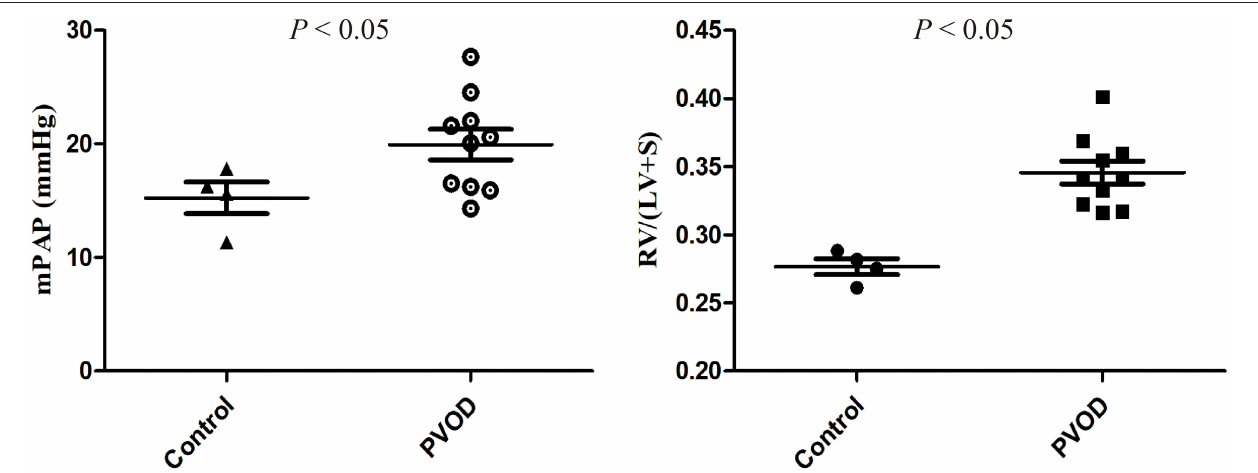
FIGURE 3 | The mPAP and RVHI in control and MMC-induced PVOD rat. The control group ( n = 4 rats) and the PVOD group ( n = 10 rats). LV, left ventricular; mPAP, mean pulmonary arterial pressure; MMC, mitomycin-C; PVOD, pulmonary veno-occlusive disease; RVHI, right ventricular hypertrophy index; S, interventricular septum; RVHI = RV/(LV +